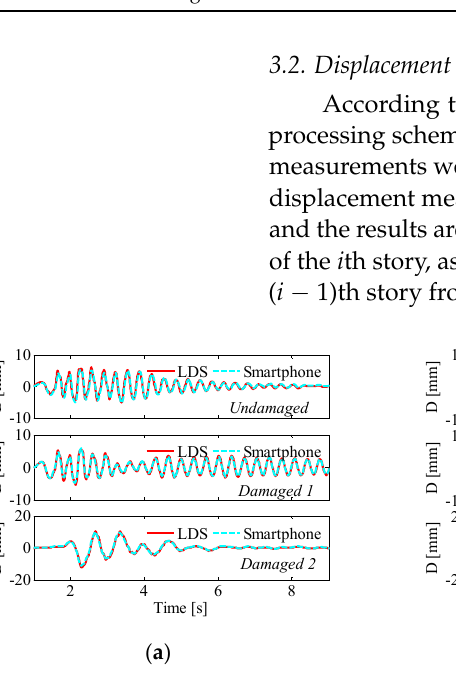
Table 2. Maximum displacements as recorded by the laser displacement sensors and smartphones.